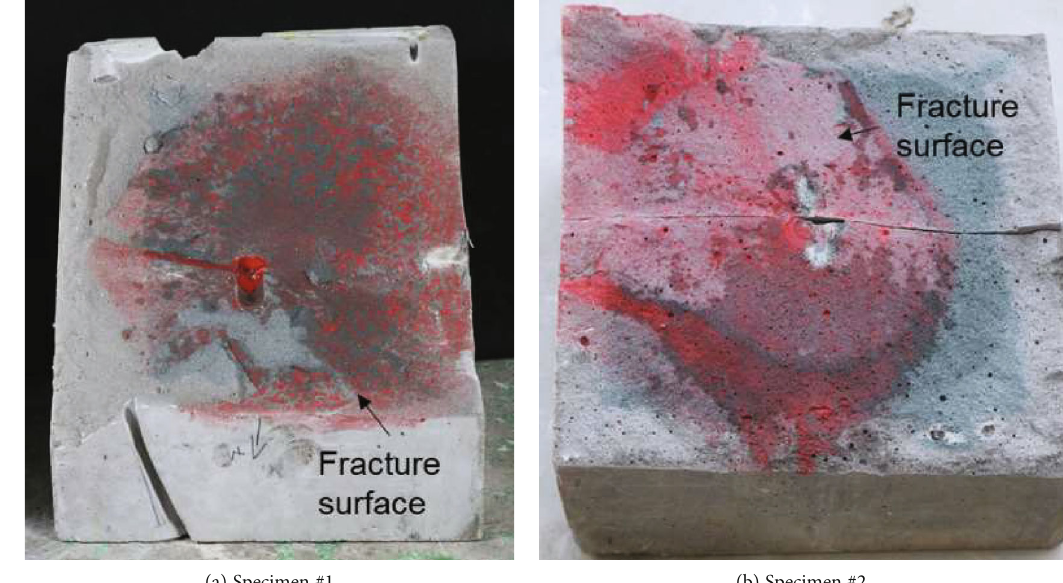
Figure 3: Hydraulic fracture shape of the